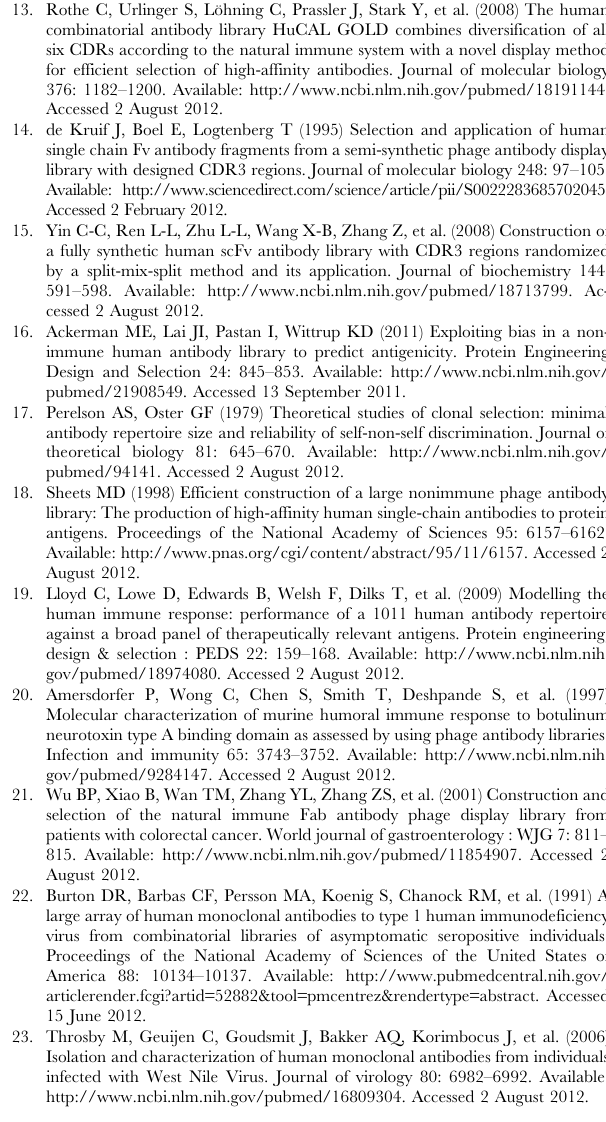
Figure S5 Screening of selections outputs from biased and naive murine libraries in phage format – Second example. The supernatants of random clones from the selection round 2 against hIL6 receptor were tested independently in phage ELISA against the same target (88 clones tested for each library). Clones were then ranked according to their level of absorbance at 450 nm. Were defined ‘‘high’’, clones with absorbance values above 70% of the signal of a positive control scFv (absorbance , 1.6), ‘‘medium’’, clones between 10% and 70% (absorbance between 0.2 and 1.6) and ‘‘negative’’ clones below 10%. Histograms show the percentage of clones relative to their corresponding level of absorbance. See also Materials and Methods S1 B. Figure S6 Specificity ELISA. (A) Fifteen scFv isolated from the different libraries were tested in ELISA at three different concentrations (1100, 110 and 11 nM, n= 2) against hIFN c and a panel of irrelevant targets, i.e. streptavidin, lysozyme, three human IgGs (VH3/V l 6, VH4/V k 6, VH1/V l 3), horseradish